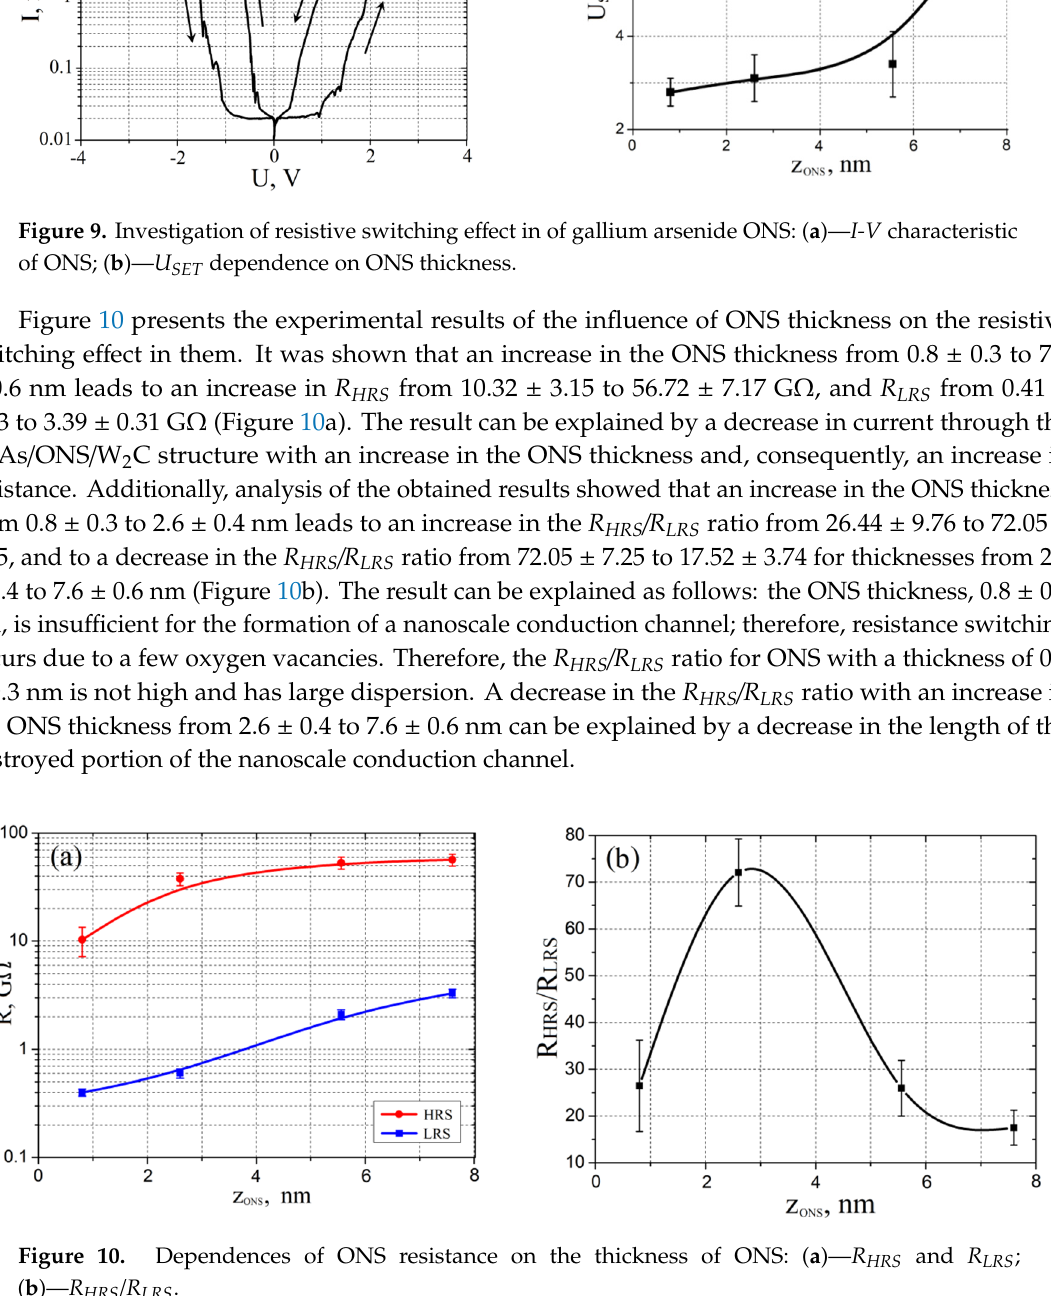
Figure 10. Dependences of ONS resistance on the thickness of ONS: ( a )— R HRS and R LRS ; ( b )— R HRS / R LRS .